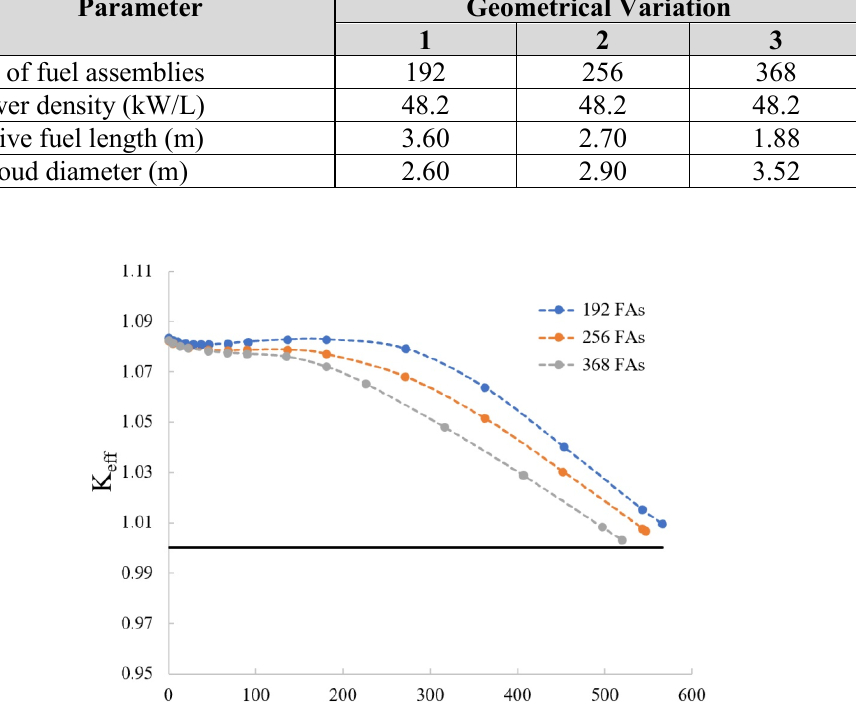
Figure 5. Comparison of The Multiplication Factor for The Studied